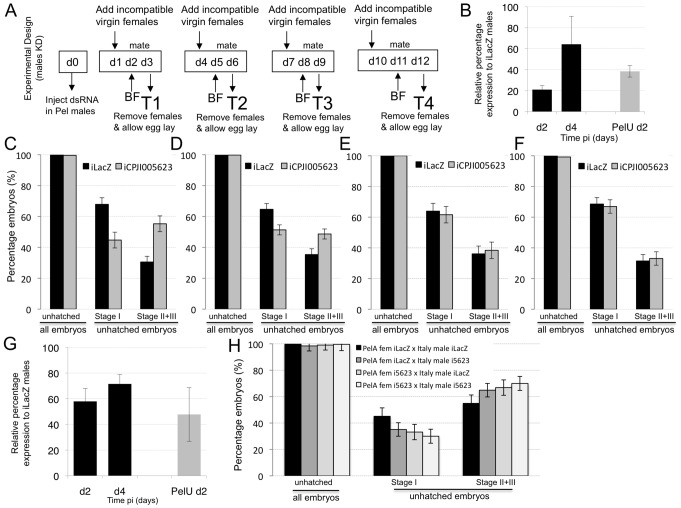
Knockdown analysis of CPIJ005623 in C. pipiens males.
A. Diagram representing experimental design of knockdown (KD) experiments, d-day post pupal eclosion, BF- Blood feed, T-time point. B. KD assessment of iCPIJ005623 in Pel testis. Reduction of CPIJ005623 mRNA levels was observed in testis when CI developmental progression was seen. C–F Embryo developmental progression after iCPIJ005623 males in an incompatible Italy female cross. Timepoints under dsRNA early effect (C-T1; D-T2) show an increased proportion of Stage II&III embryos compared to control KDs. No effect was seen at later time points (E-T3; F-T4). G. KD assessment of iCPIJ005623 in Italy testes. H. Double KD analysis of CPIJ005623 in Pel females crossed to Italy males. Increased developmental progression is detected in female, male and double iCPIJ005623.